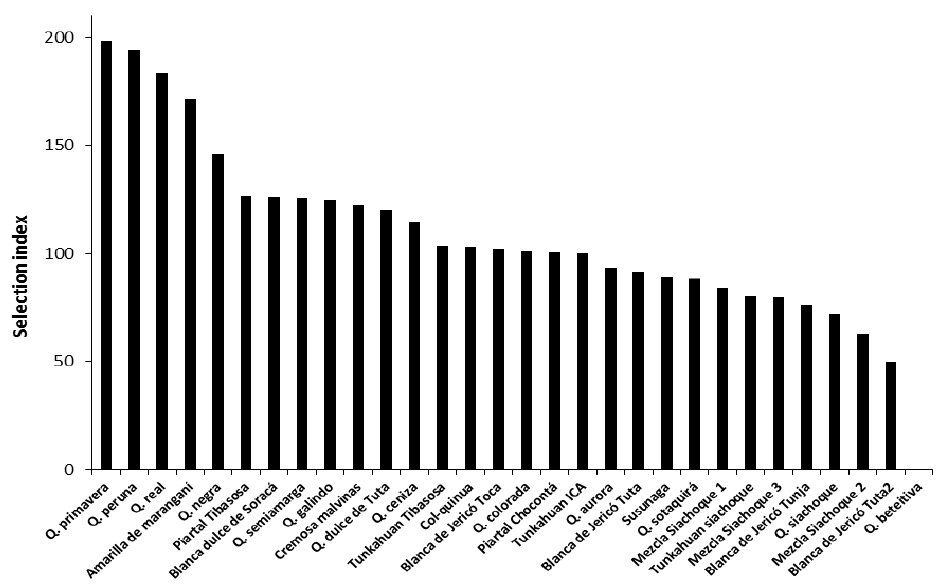
Figure 8. Values of the selection index for each of the evaluated quinoa accessions ( C. quinoa ), showing the discrimination of accessions according to agronomic characteristics.